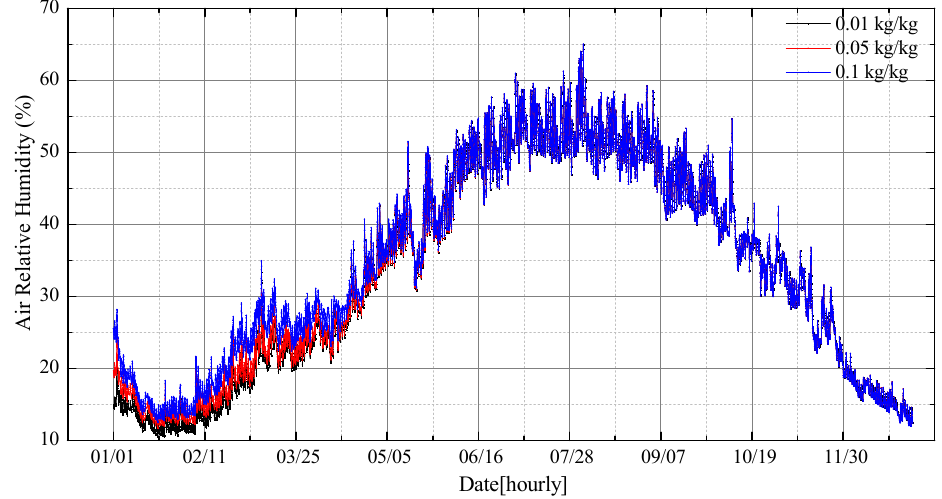
Figure 14. Relative humidity under different initial moisture contents of hygroscopic materials.